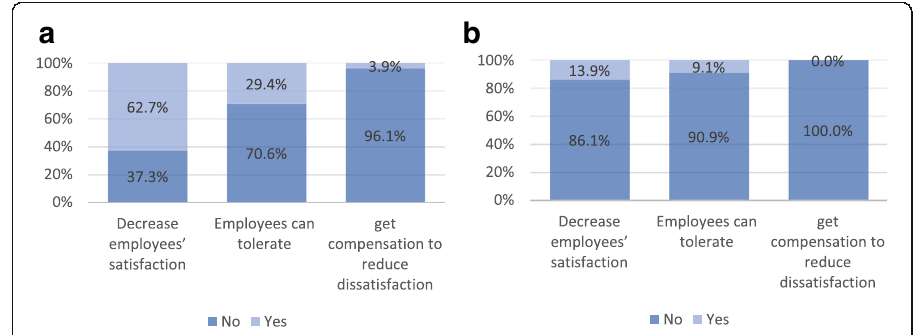
Fig. 10 a the percentage of surveyed Danish managers ’ beliefs on employees ’ satisfaction due to dynamic control. N = 51 . b the percentage of surveyed Philippines managers ’ beliefs on employees ’ satisfaction due to dynamic control. N = 36